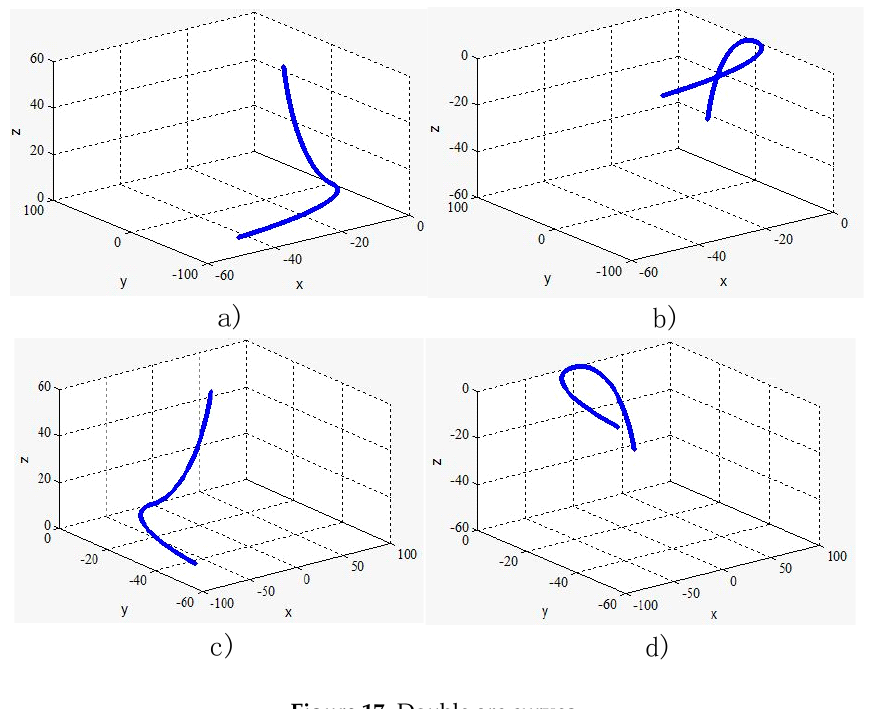
Figure 17. Double arc curves.